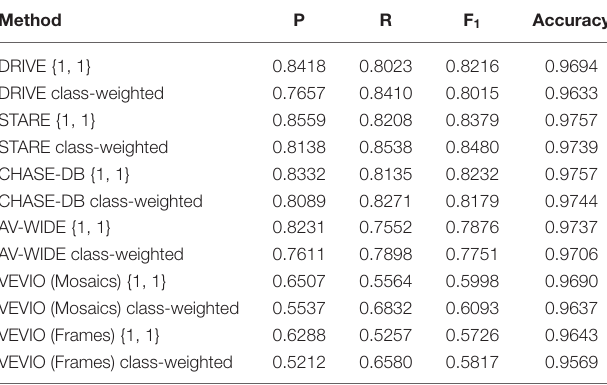
TABLE 7 | Equal weights {1, 1} vs. class-based weights.